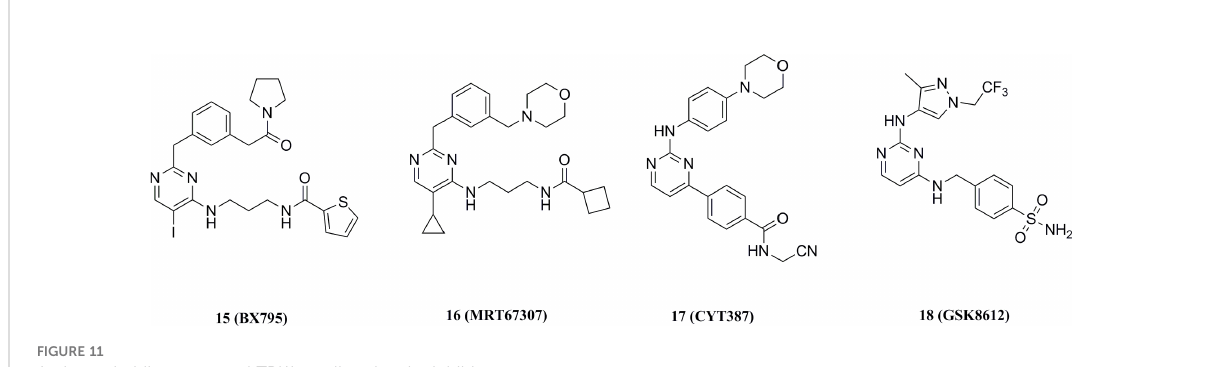
FIGURE 11 Aminopyrimidine structural TBK1 small molecular